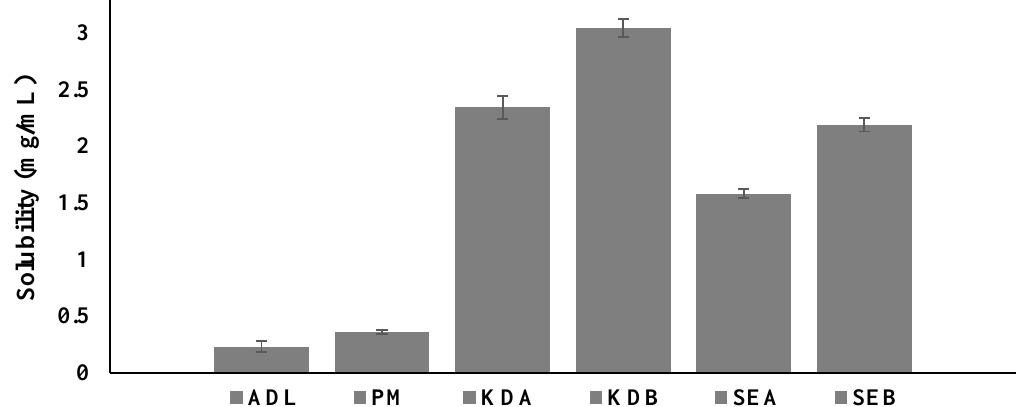
Figure 2. Aqueous solubility of pure ADL and the PM and their binary and ternary complexes. Arbidol (ADL); physical mixture (PM); binary kneaded ADL/β-CD (KDA); ternary kneaded ADL/β-CD with 1% poloxamer 188 (KDB); binary solvent evaporated ADL/β-CD (SEA); ternary solvent evaporated ADL/β-CD with 1% poloxamer 188 (SEB).